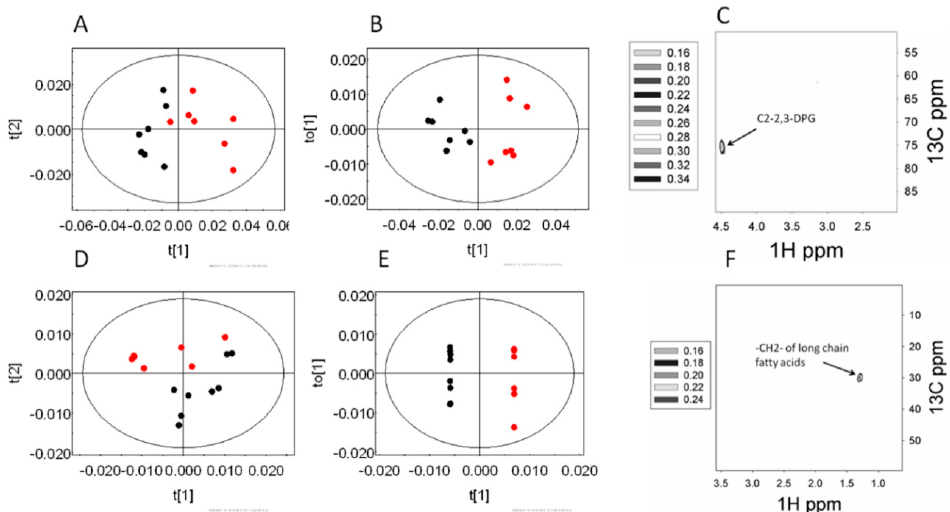
Figure 2. The changes in the labeling patterns from (2 13 C)glucose in the RBCs of early stage infection (~1% parasitemia) and uninfected control mice. ( A – C ) hydrophilic extract, and ( D – F ) hydrophobic extract of the RBC. ( A , D ) Principal component analysis (PCA) score plot and ( B , E ) orthogonal partial least square discriminant analysis (OPLSDA) score plots of the corresponding models; black—early stage, and red—control animals. ( C , F ) Relevant OPLSDA loadings plot. The contour levels indicate the OPLSDA loadings.